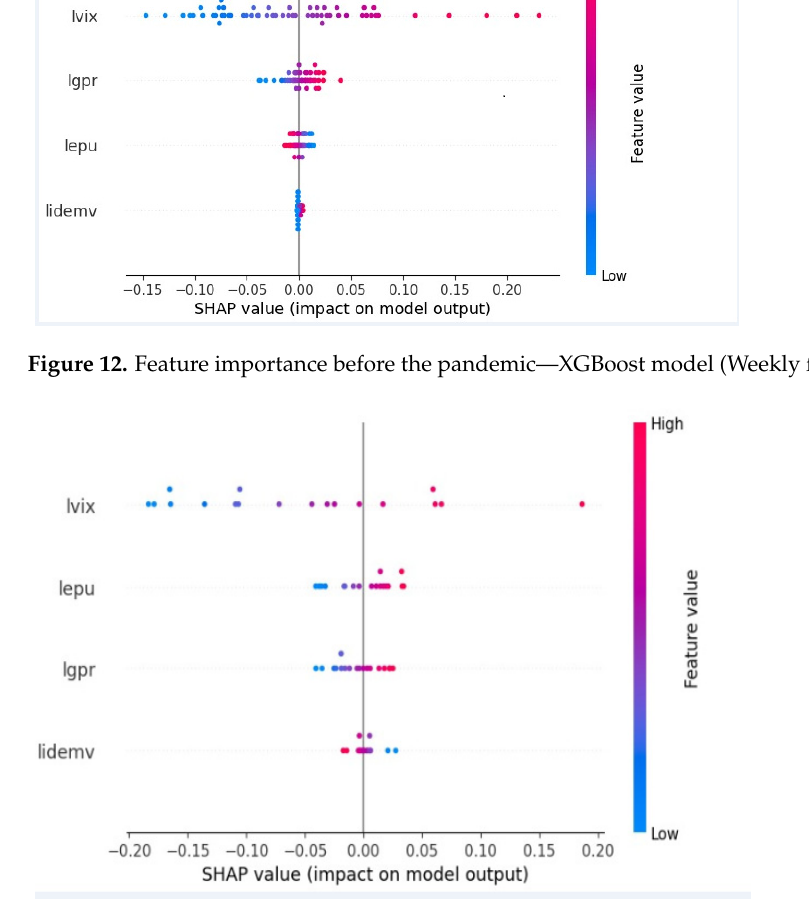
Figure 13. Feature importance during the pandemic—SVM model (Weekly frequency).